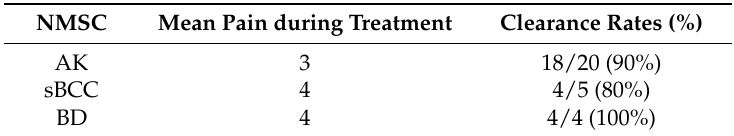
NMSC, nonmelanoma skin cancers; AK, actinic keratosis; sBCC, superficial BCC; BD, Bowen disease; Mean pain score on a visual 11-point scale (0, no pain; 10, insufferable